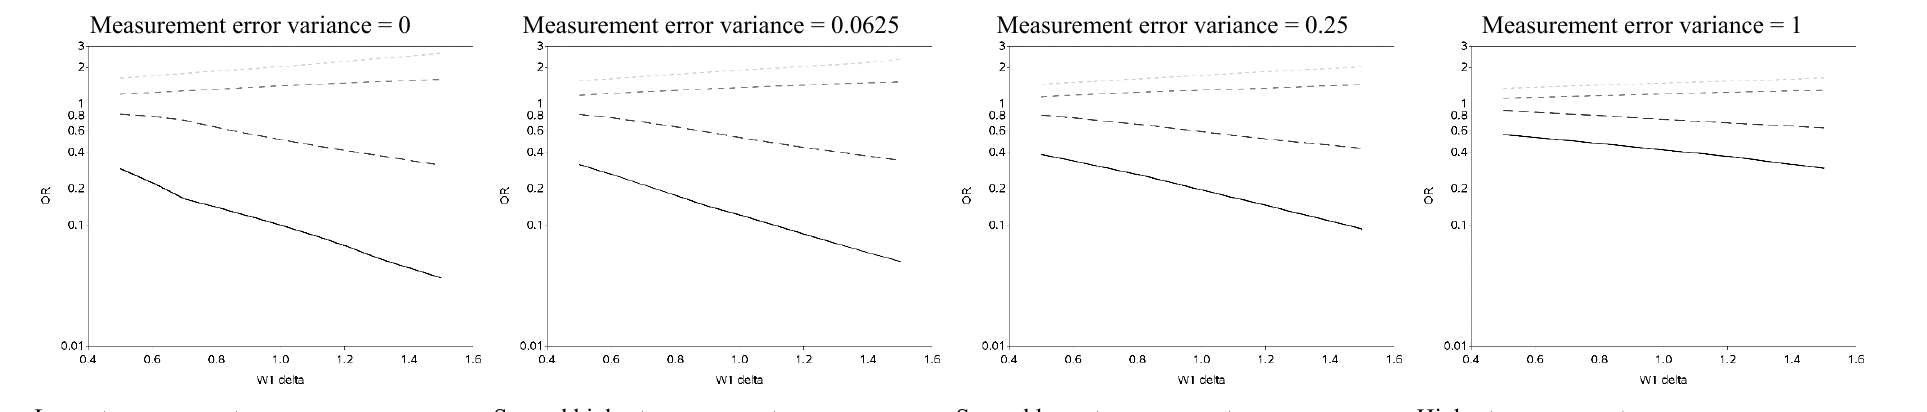
Figure A2. Odds ratios (OR) for different cutoffs used to create 5 categories for the causal yet mismeasuered exposure (W 1 ) (all scenarios for Figure 3) (δ is identified as “W1 delta” in the figure). The 4 W1 cutoffs were centered at 0 with δ from 0.5 to 1.5 standard deviations, in increments of 0.1. Reference category for W1 is mean +/− (0.5 × δ × standard